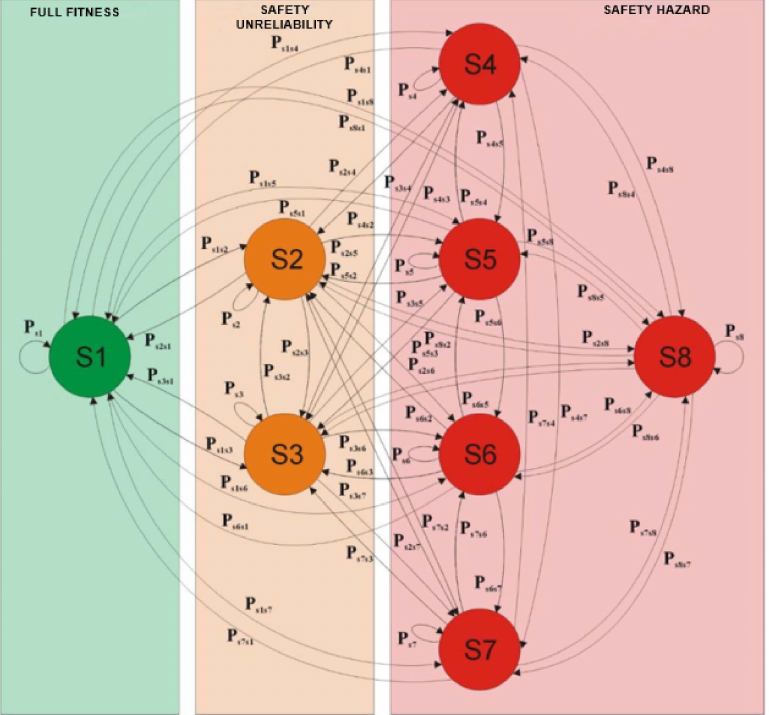
Figure 8. The Markov chain for an FAS consisting of a single FACU and two fire detectors—Cz1, Cz2, where P S1S2 is the probability of transition between state S1 and S2, P S2S1 is the probability of transition between state S2 and S1, etc., P s1 , P s2 , . . . , etc. are the probabilities of the FAS remaining in the distinguished states S1, S2, . . . ,